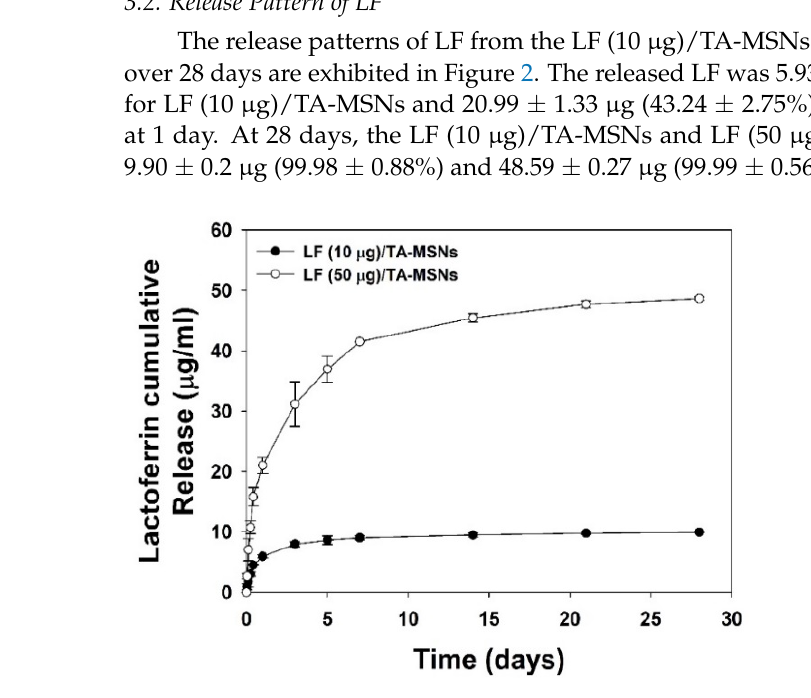
Figure 2. In vitro cumulative release patterns of LF from the LF (10 μ g)/TA-MSNs and LF (50 μ g)/TA-MSNs ( n = 4 per